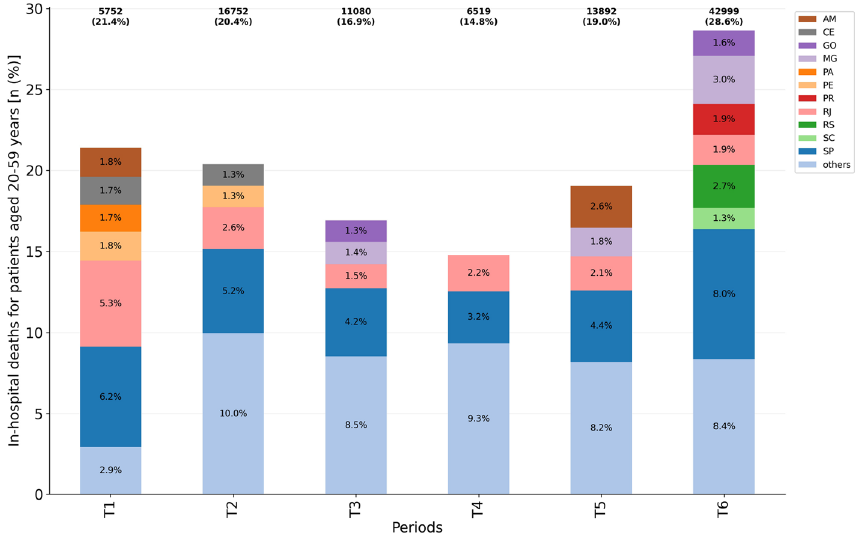
Figure 6. In-hospital deaths for patients aged 20–59 years with closed outcome (cure or death) per considered period ( n = 96,994 ). Federative units showing proportions ≥ 1.3 were highlighted while ‘others’ accounts for the grouping of those presenting a proportion < 1.3